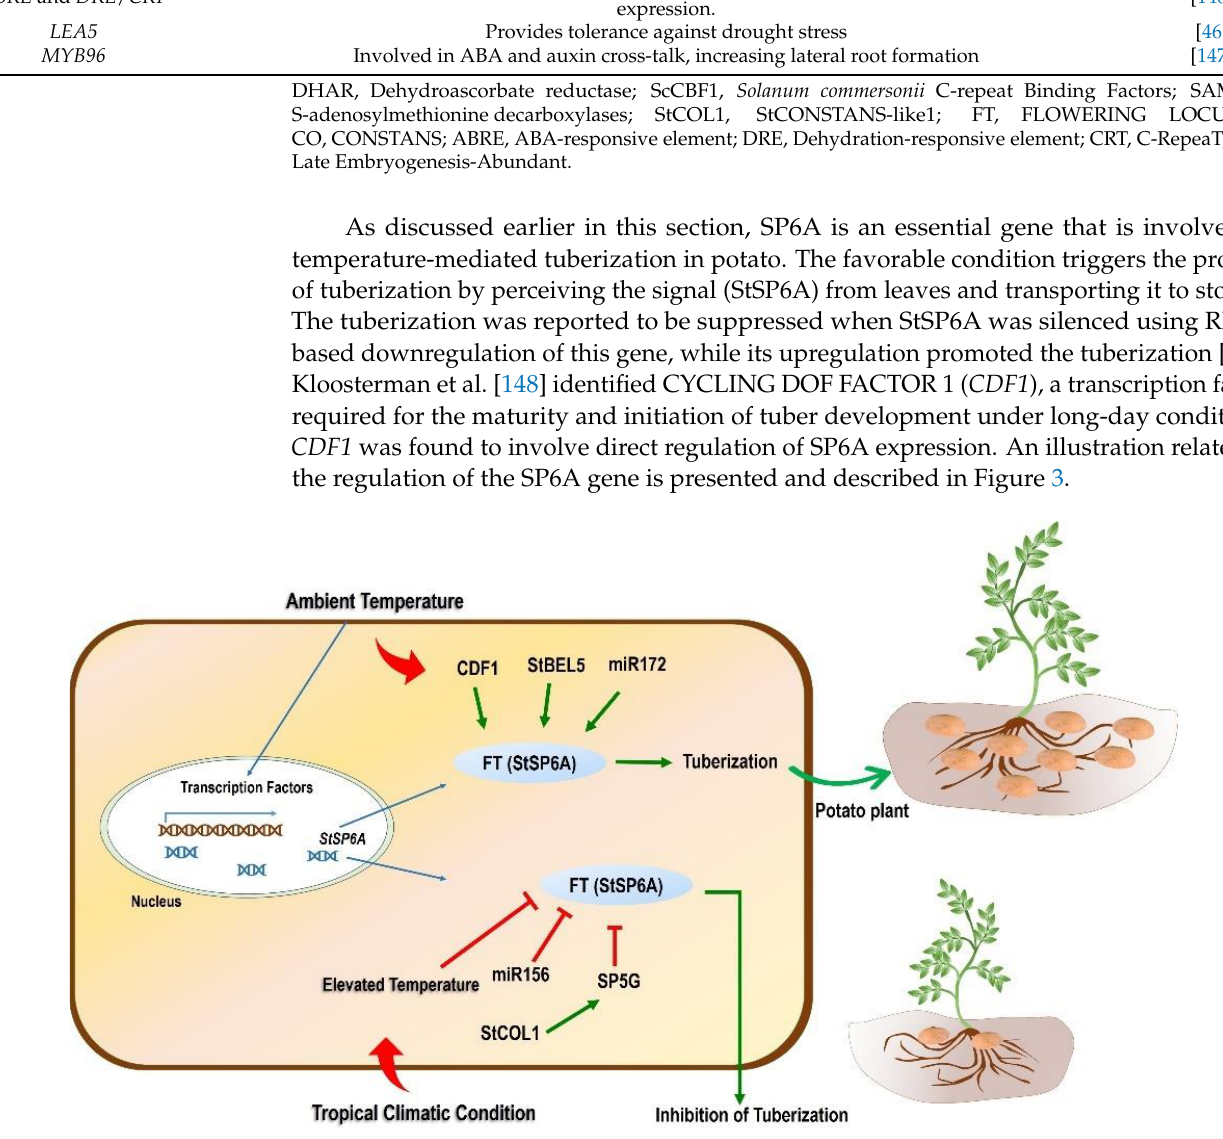
Figure 3. Schematic model of the effect of tropicalization on tuberization. Temperature plays an important role in the expression of essential genes responsible for tuberization. The master regulator for tuberization in potato is the FT(StSP6A) gene responsible for tuberization under normal/ambient temperature conditions. Different TFs and miRNA also control the process of tuberization through an StSP6A-mediated mechanism. TFs such as CDF1 and StBEL5 upregulate the expression of StSP6A, whereas miR172 also upregulates this gene, leading to tuberization. However, when the potato is grown in tropical conditions and is subjected to high temperatures, tuberization is inhibited. An FT family member, SP5G downregulates the expression of the StSP6A gene. The former SP5G is reported to be regulated positively by StCOL1 expression. Moreover, miR156 also negatively controls the expression of StSP6A, which ultimately inhibits tuberization. CONSTANS-LIKE protein 1: StCOL1; CYCLING DOF FACTOR 1: StCDF1; BELLRINGER-1 LIKE 5: